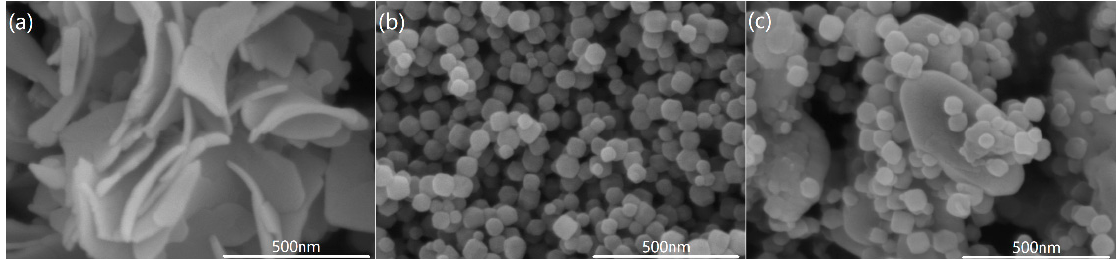
Figure 2. SEM images of ( a ) BVO, ( b ) ZIF-8, and ( c ) ZIF-8@BVO.